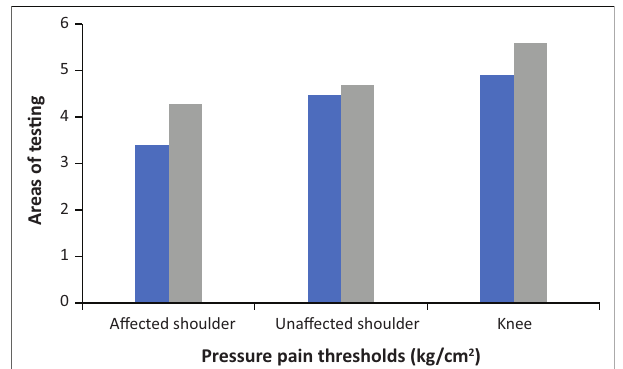
FIGURE 1: Pressure pain thresholds (kg/cm 2 ) before (blue) and after (grey) pain neuroscience education.